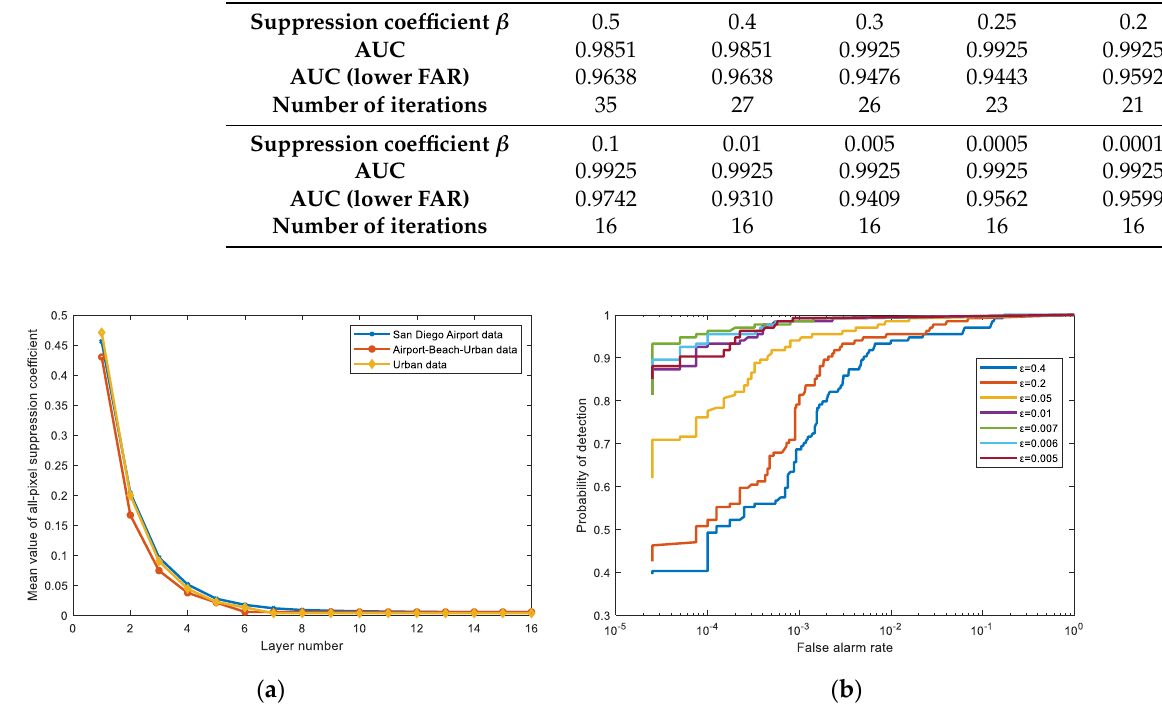
Figure 13. ( a ) The mean value of all pixels’ suppression coefficient in different layers on three different datasets. ( b ) The ROC curves comparison for different ε values where ε value contains 0.4, 0.2, 0.05, 0.01, 0.007, 0.006, and 0.005. Table 6. The number of iterations and detection performance for different ε values.